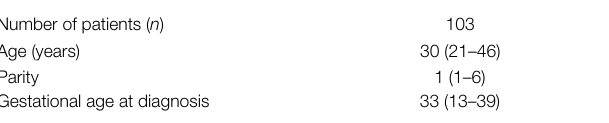
TABLE 1 | Characteristics of patients with cholestasis of pregnancy [the data is presented as median (range)]. Number of patients ( n